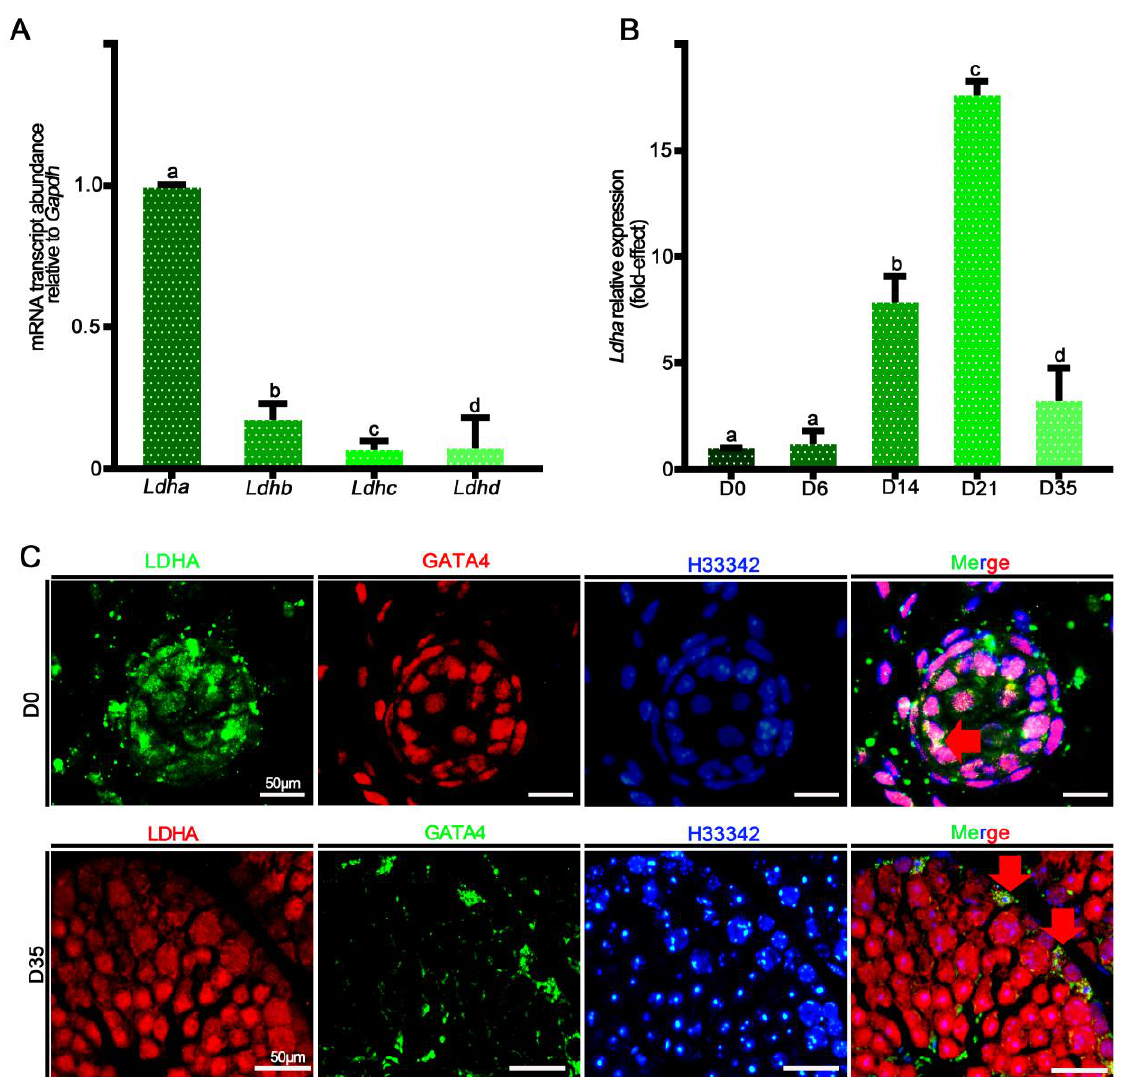
Figure 1. The relative mRNA expression of Ldha-d and protein localization of LDHA. ( A ) Analysis of Ldha-d mRNA expression in mouse testes. ( B ) Quantification of the mRNA expression of Ldha in Sox9 + cells at different developmental stages. Data were analyzed as the mean ± s.e.m. of 3 mice per stage. a, b, c, and d denote significance at p < 0.05. ( C ) Co-immunofluorescence staining for LDHA and GATA binding protein 4 (GATA4) at D0 and D35 in cross-sections of testes. (Scale bar = 50 μm). The arrow indicates overlapping staining.